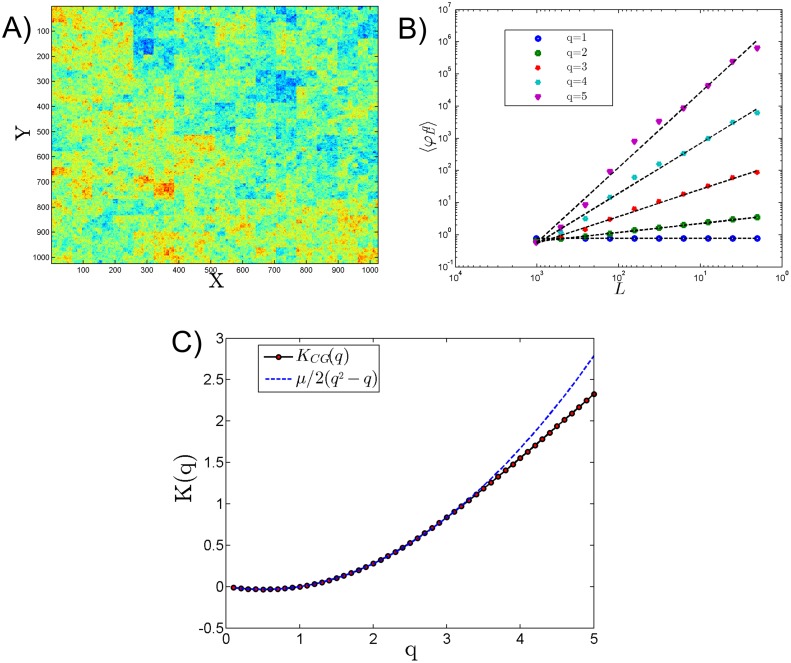
A) Simulation of a 2D log-normal image using a discrete cascade model with μ = 0.3, B) coarse grained moments from q = 1 to 5 and C) the corresponding moment scaling function experimentally estimate as dots and theoretical value K(q)=μ2(q2−q) as a dotted line.